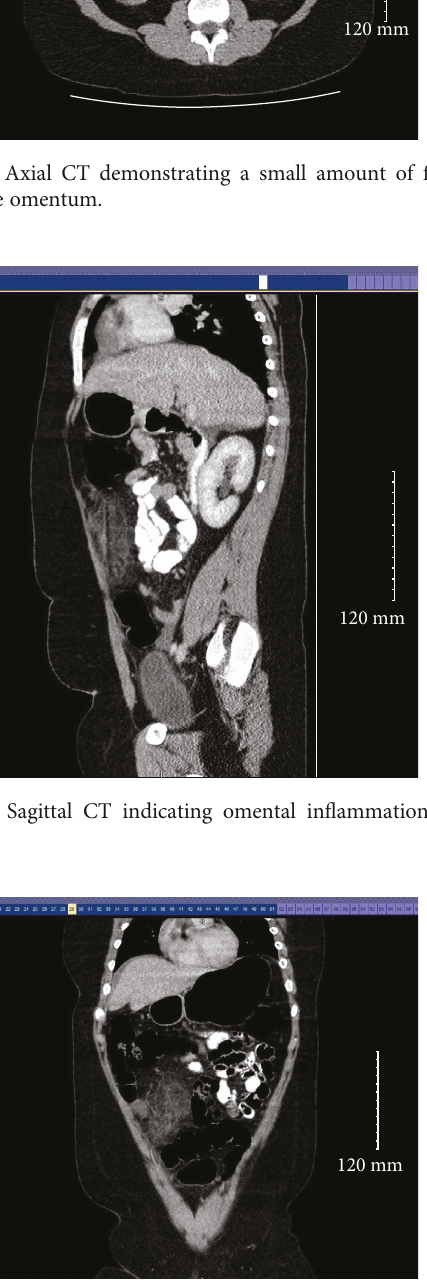
Figure 3: Coronal CT having signs of omental